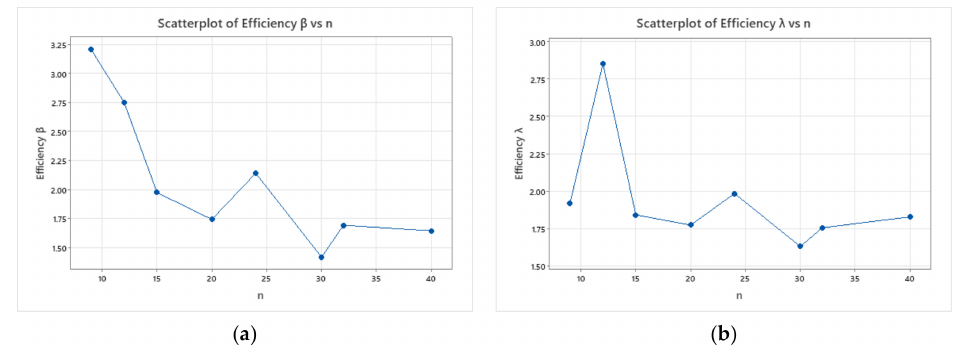
Figure 1. The efficiency of the MLE parameters β ( a ) and λ ( b ) when β = 1 and λ = 1.